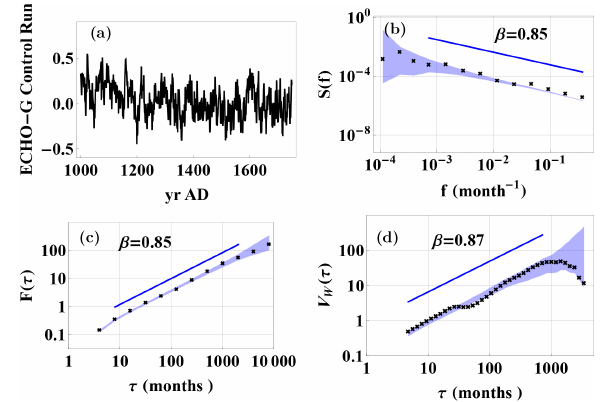
Figure 11. (a) One-year average of the temperature from the ex- periment Erik1 (black) and deterministic response (red). (b) The residual from the deterministic response. (c) PSD from the residual (black crosses) and linear fit to the PSD in the scale range indicated by the red line segment. The value β = 0 . 86 estimated from this line segment is indicated in the figure. (d) DFA2 applied to the residual (black crosses).The straight line segment is a linear fit to the dots in the range indicated by the length, and position of the line segment and the slope yields an alternative estimate β = 0 . 72 for the resid- ual, indicated in the figure. The shaded areas in (c) and (d) show the 95% confidence range for synthetic fGn with β = 0 . 74 estimated by MLE using the response model.